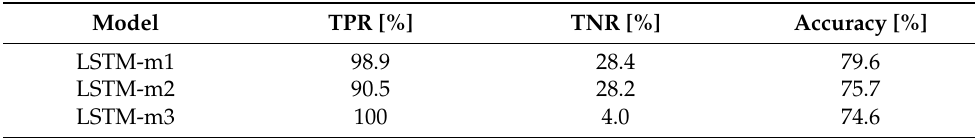
Table 10. Test results of the LSTM-based anomaly detection models.